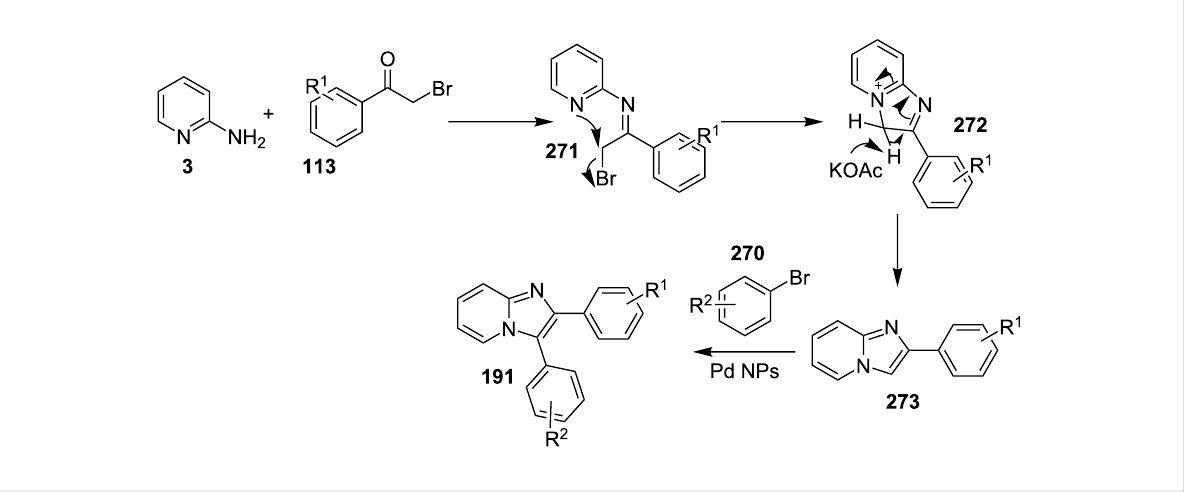
Scheme 91: Plausible mechanistic pathway for Pd NPs-catalyzed MCR.